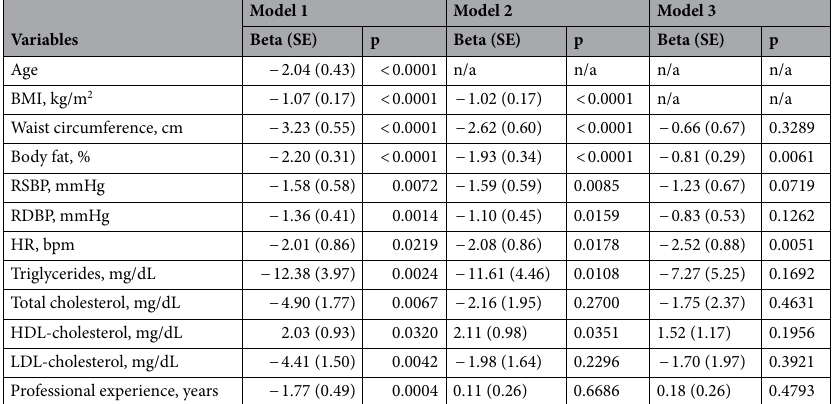
Table 4. Linear regression models of cardiovascular risk factors and METS as continuous variable. Model 1: linear regression, unadjusted. Model 2: linear regression, adjusted for age. Model 3: linear regression, adjusted for age and BMI. BMI body mass index, HR heart rate, RDBP diastolic resting blood pressure, RSBP systolic resting blood